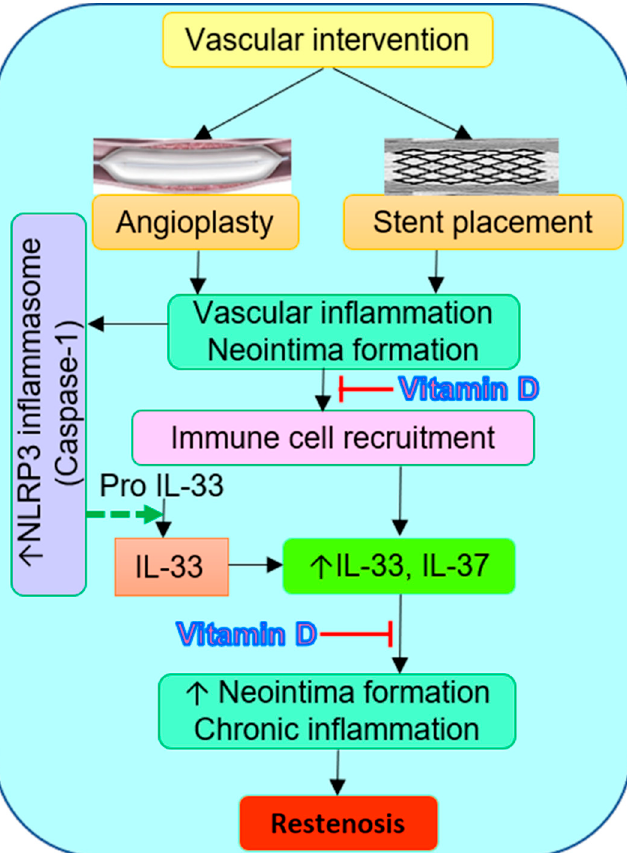
Figure 7. Schematic presentation of vascular intervention mediated inflammation and increased IL-33 expression, and the role of vitamin D in attenuating chronic inflammation and neointima formation and hyperplasia. Vascular intervention, namely balloon angioplasty and stent implantation, causes endothelial injury and vascular inflammatory response, leading to the recruitment of inflammatory immune cells like macrophages. This results in increased secretion of proinflammatory cytokines, including IL-33, and endues inflammation in the denuded area. Chronic inflammation and activation of various inflammatory cascades leads to neointima hyperplasia and restenosis. Vitamin D acts as an immunomodulator and anti-inflammatory agent and regulates the secretion of IL-33 and macrophages phenotypic polarization. Thus, vitamin D supplementation, to decrease the secretion of inflammatory cytokines and neointimal hyperplasia, might be a potential therapeutic strategy.